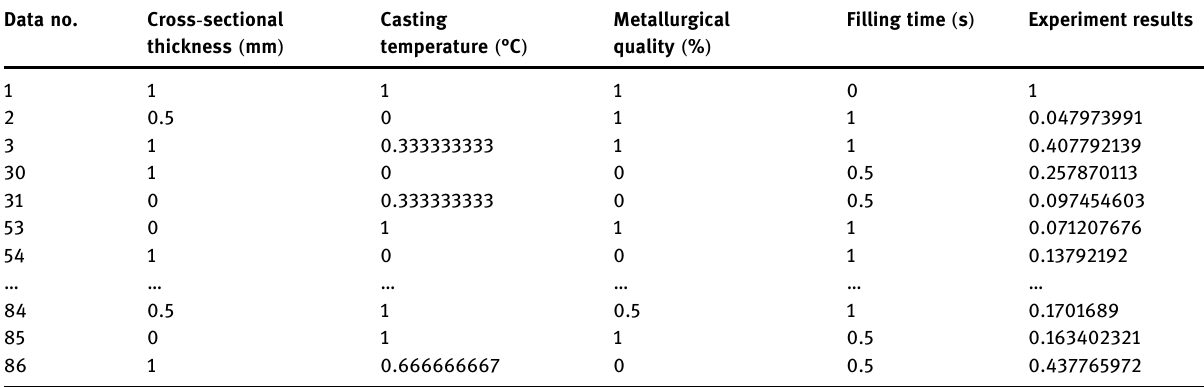
Table 4: An example section of the normalized training set Data no.